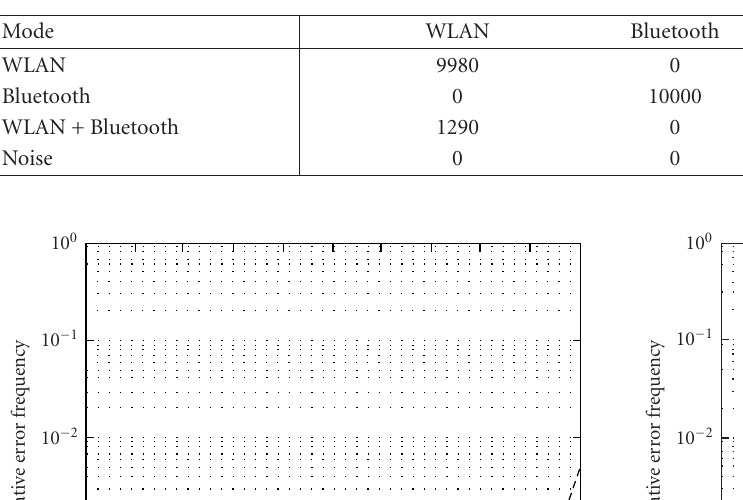
Table 4: Confusion matrix.